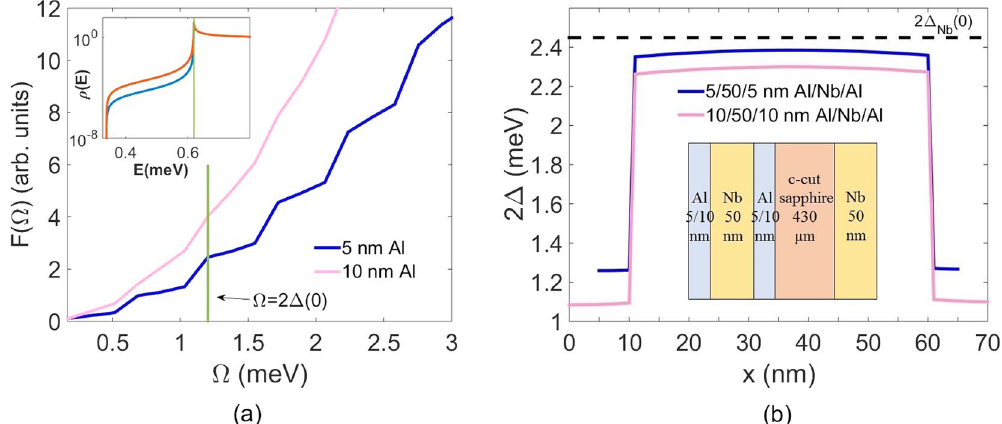
Figure 1. ( a ) Calculated total phonon density of states as a function of phonon energy for 5 nm and 10 nm Al films. The vertical line shows where the gap energy 2 Δ (0) for 5 nm Al in the heterostructure is located. The inset illustrates how quasiparticle DOS at T = 1.2 K broadens when θ varies from 10 − 4 (cyan curve) to 6 × 10 − 4 (red curve). The vertical line shows where the quasiparticle energy equaling to Δ (0) for 5 nm Al in the heterostructure is located. ( b ) Calculated superconducting pair potential distribution with depth for 5/50/5 and 10/50/10 nm Al/Nb/Al heterostructure. The dashed line is the gap energy for a single 50 nm Nb layer determined from our experiment. The inset is the schematic illustration of the Al/Nb/Al heterostructure on a double-side-polished c-cut sapphire. The back side is coated with 50 nm